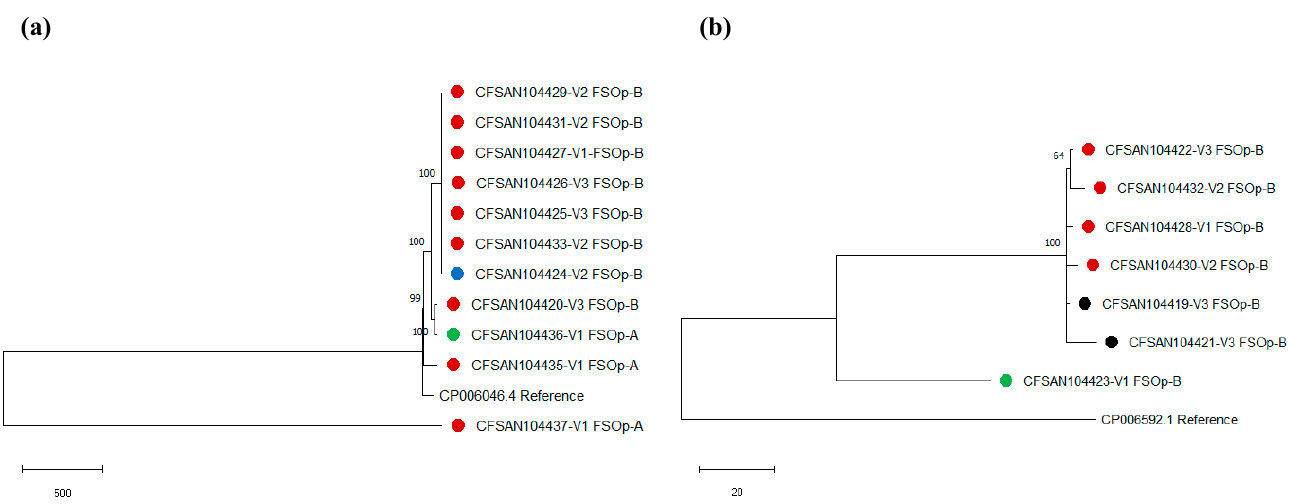
Figure 2. Neighbor-joining phylogeny of isolates based on SNP of L. monocytogenes by serogroup ( a ) IVb and ( b ) IIb. The circle color indicates isolation source: Red = drain; green = food; black = floor; and blue = boot cover.